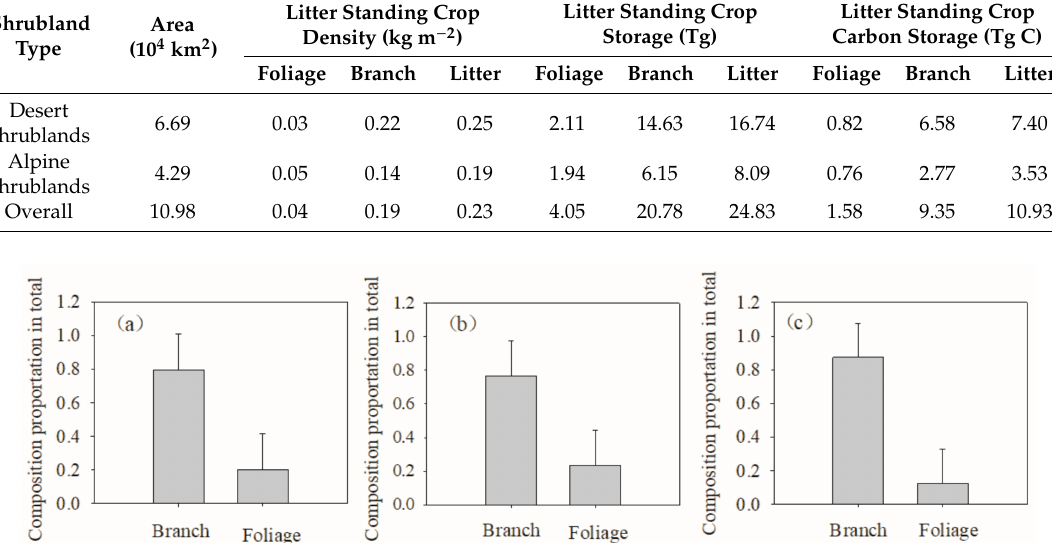
Figure 2. The proportions of branch and foliage standing crop in the litter standing crop on the Tibetan Plateau, ( a ) all shrublands, ( b ) alpine shrublands, ( c ) desert